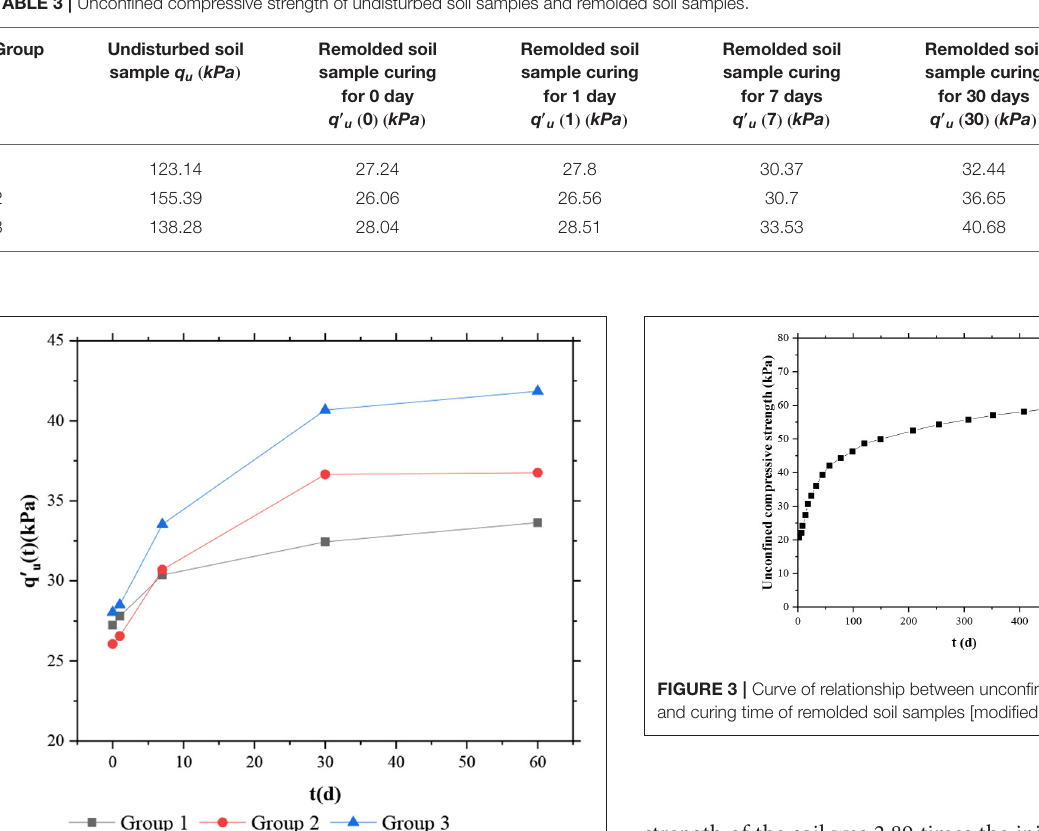
strength of the soil was 2.89 times the initial strength, as shown in Figure 3